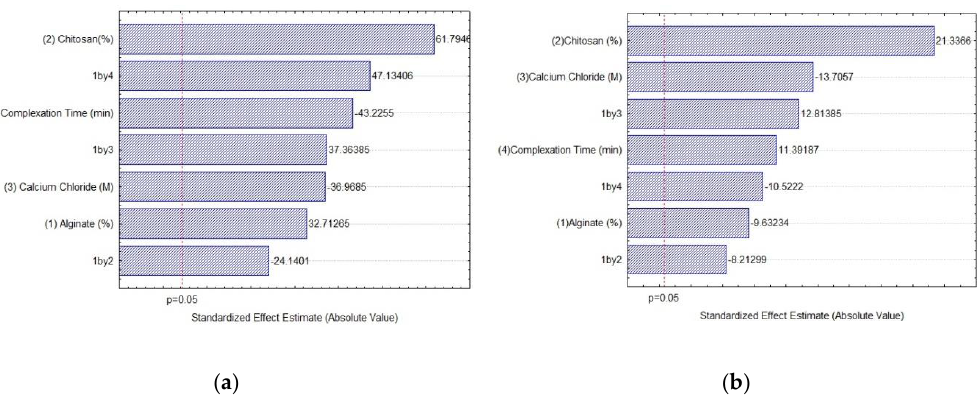
Figure 1. Pareto diagram for the estimated effect of each variable of the 2 4-1 fractional factorial design: ( a ) Immobilization yield; ( b ) immobilized lipase activity. The point at which the effect estimates were statistically significant (at p = 0.05) is indicated by the broken vertical line.